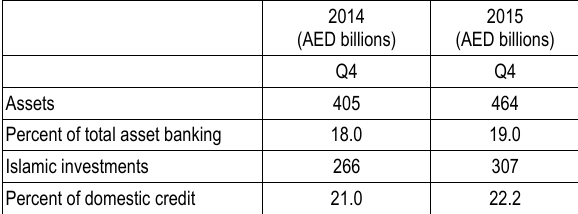
Table 1. Assets of Islamic banks in UAE (2014-2015)